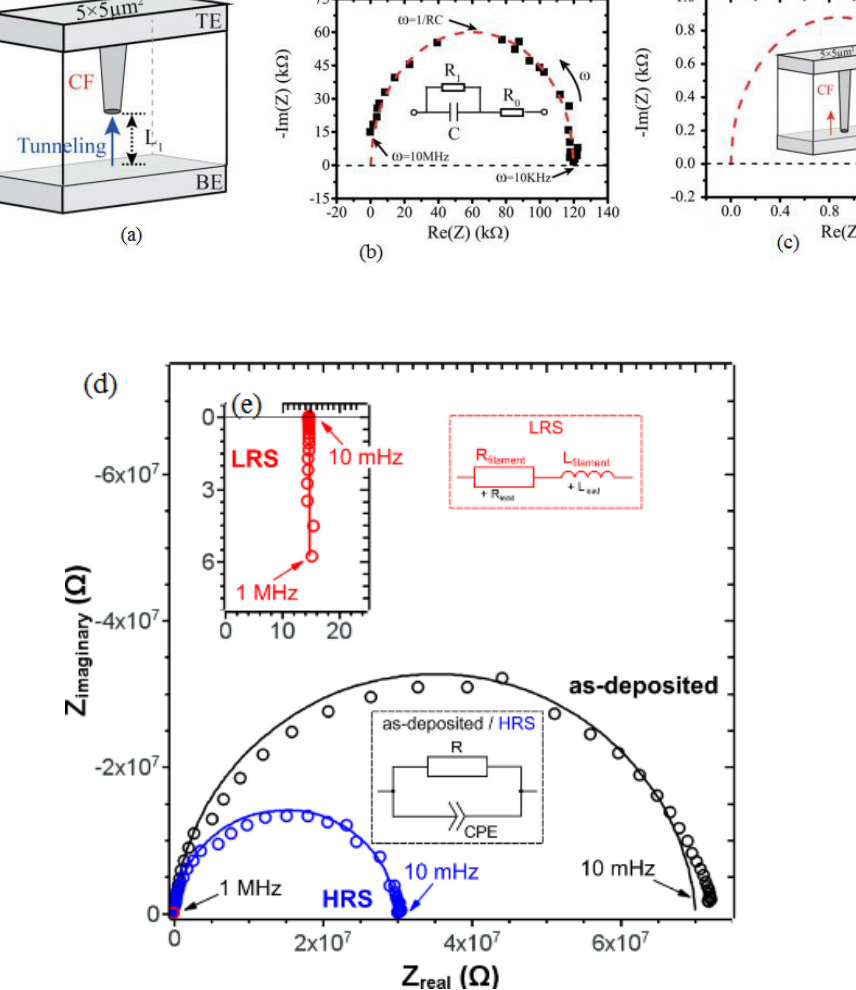
Figure 9: Impedance spectra of the Pt /TiO 2+ x /TiO 2 / Pt ReRAM structure (a) Device is in HRS as the conducting filament do not connect the top and bottom electrode. Impedance spectrum at (b) HRS (c) LRS. Impedance spectra of the Au/Mn 3 O 4 /AuPd ReRAM in (d) pristine state (black), high resistance state (HRS, blue), and (e) low resistance state (LRS, red). Points corresponds to experimental results and lines are fitted to generate the equivalent circuits, which are presented as insets. A constant phase element (CPE) is used to model the capacitor. (Reprinted with permission from J. A. Koza, I. P. Schroen, M. M. Willmering, and J. A. Switzer // Chem. Mater. 26 (2014) 4425 (C) 2014 American Chemical